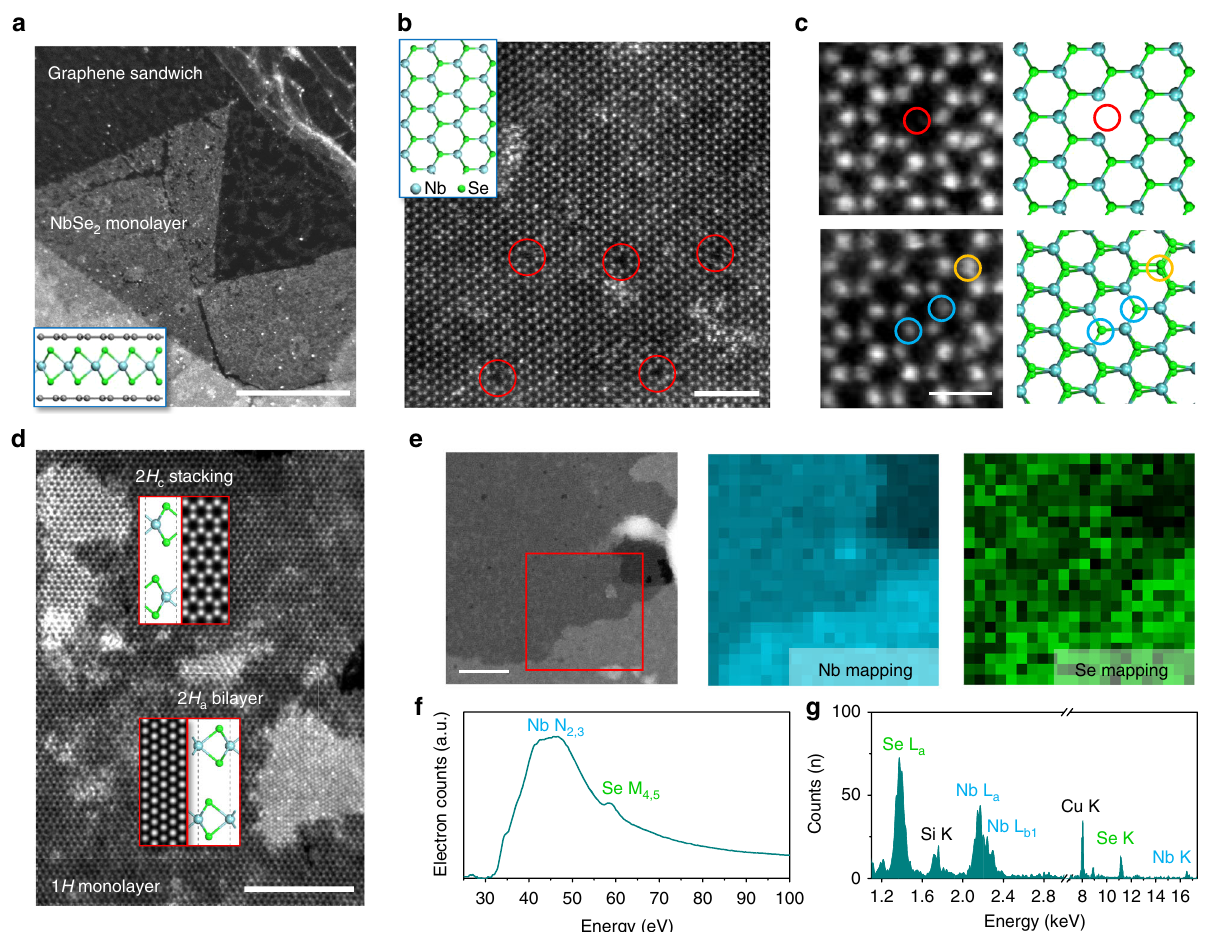
Fig. 2 ADF-STEM images, EELS, and EDX characterizations of the as-synthesized NbSe 2 atomic layers. a A low magni fi ed annular dark- fi eld scanning transmission electron microscope ( ADF-STEM ) image showing a large region of monolayer NbSe 2 encapsulated by the graphene sandwich. The schematic is shown in the inset . b Atomic resolution ADF-STEM image of the hexagonal NbSe 2 lattice. Diselenium vacancies are highlighted by red circles . The inset of panel b shows the structural model of 2 H -NbSe 2 , with cyan and green color indicating Nb and Se atoms, respectively. c Different point defects in monolayer NbSe 2 and their atomic models. Diselenium vacancy, monoselenium vacancy, and anti-site defect Se Nb are highlighted by red , blue , and yellow circles , respectively. d Atomic resolution ADF-STEM image of two bilayer islands in NbSe 2 , showing the coexistence of 2 H a and 2 H c stacking sequence. The insets are corresponding atomic models and simulated STEM images. e STEM image of a large region of NbSe 2 used for the collection of electron energy-loss spectroscopy ( EELS ) and energy-dispersive X-ray spectrometry ( EDX ) spectra. The collected region is highlighted in red square . Nb and Se EELS mapping are provided next to it. f Typical EELS and g EDX spectra of the region shown in e . The Cu signal in the EDX spectra comes from the Cu grid. Scale bars , 500 nm ( a ), 2 nm ( b ), 0.5 nm ( c ), 5 nm ( d ), 50 nm (